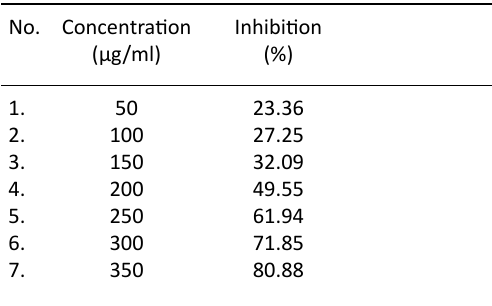
Table 3. Inhibition of KB 3-1 (Human) oral cancer cell line by the increase in the P.granatum L. peel extract